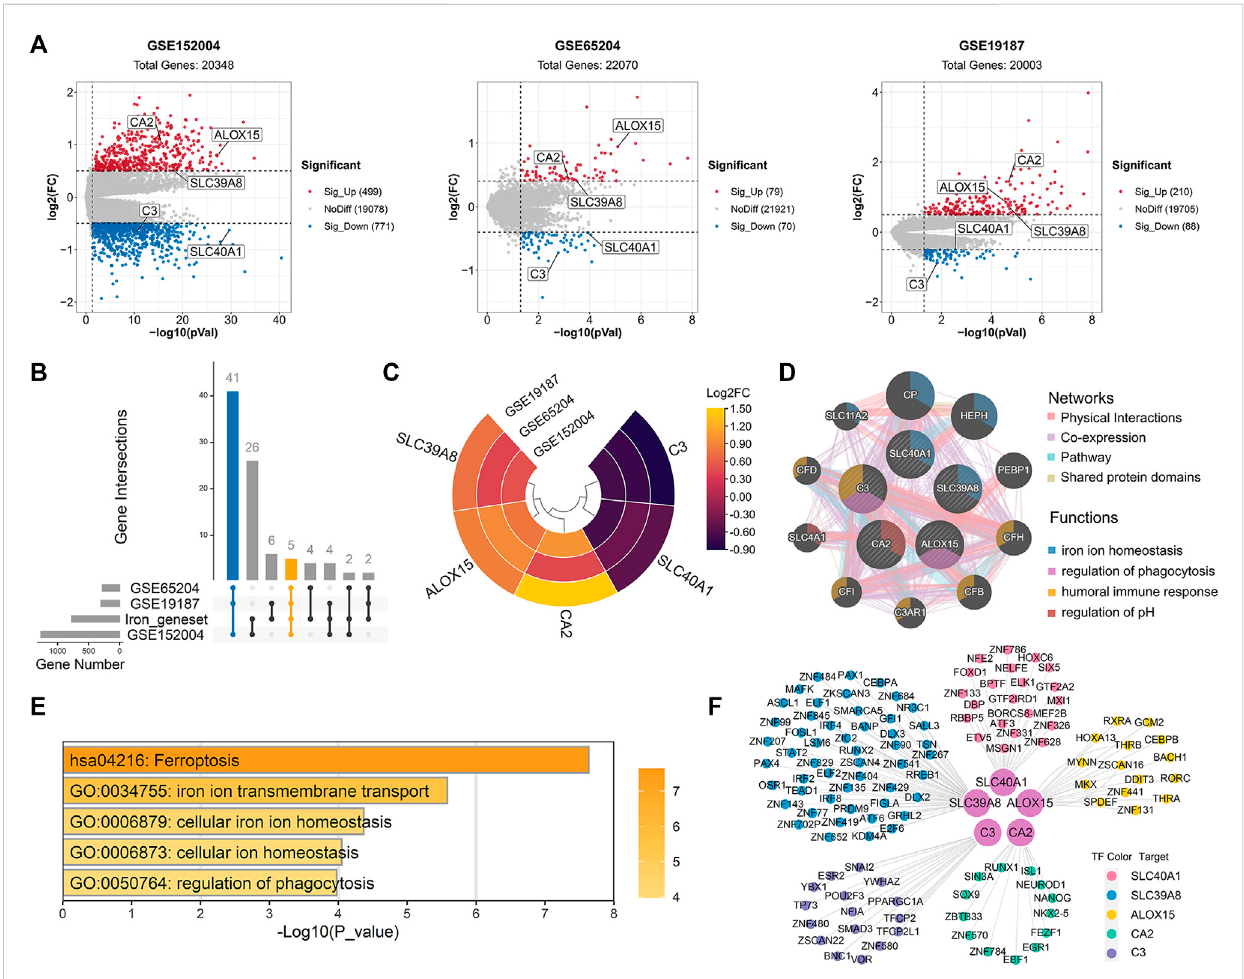
FIGURE 2 Identi fi cation and enrichment analysis of dysregulated IMR genes in childhood allergic asthma. (A) Volcano plots of DEGs between healthy controls and children with allergic asthma. (B) UpSet diagram showing overlapping DEGs and overlapping IMR DEGs among the three datasets. Datasets shared fi ve common IMR DEGs. (C) Heatmap of common IMR DEGs derived from integrated analysis. Each circle represents one dataset, and each sector represents one gene. (D) Protein-protein interaction network for common IMR DEGs using GeneMANIA database. Each node represents a protein (labelled with gene name); node color represents possible function of respective protein; and line color of connections represents different interaction type. (E) Signi fi cantly enriched GO terms and KEGG pathways of common IMR DEGs using Metascape. (F) TF-gene regulatory network of common IMR DEGs constructed using “ RcisTarget ” R package. Hub nodes represent fi ve common IMR DEGs; outer nodes represent TFs; and each color indicates enriched TFs for common IMRDEG. DEGs, differentiallyexpressedgenes;FC, fold-change; GO,gene ontology; KEGG, kyoto encyclopedia of genes and genomes; IMR, iron metabolism-related; TF, transcription